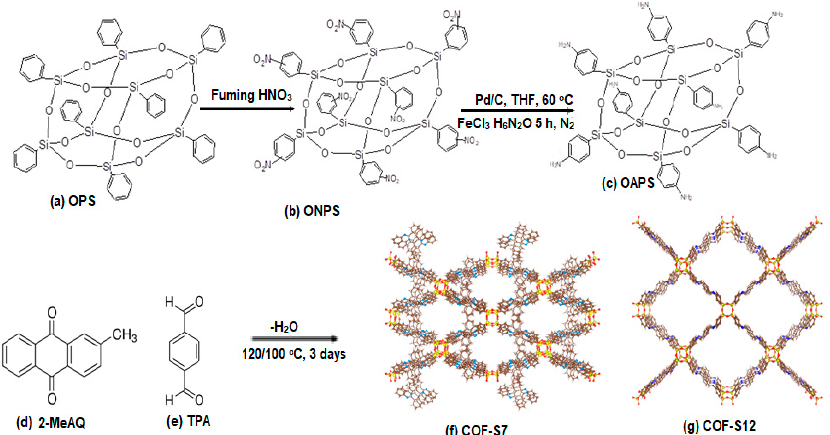
Scheme 2. Nitration of ( a ) yields ( b ), and reduction to produce ( c ). Condensation of ( c , d ) and ( c , e ) lead to the production of (molecular units) which will join together the tetrahedral building blocks D and E to produce the diamond like structures of POSS COF-S7 ( f ) and COF-S12, ( g ) single framework (space filling, C brown, O red, N blue, and Si yellow). Hydrogens were omitted for